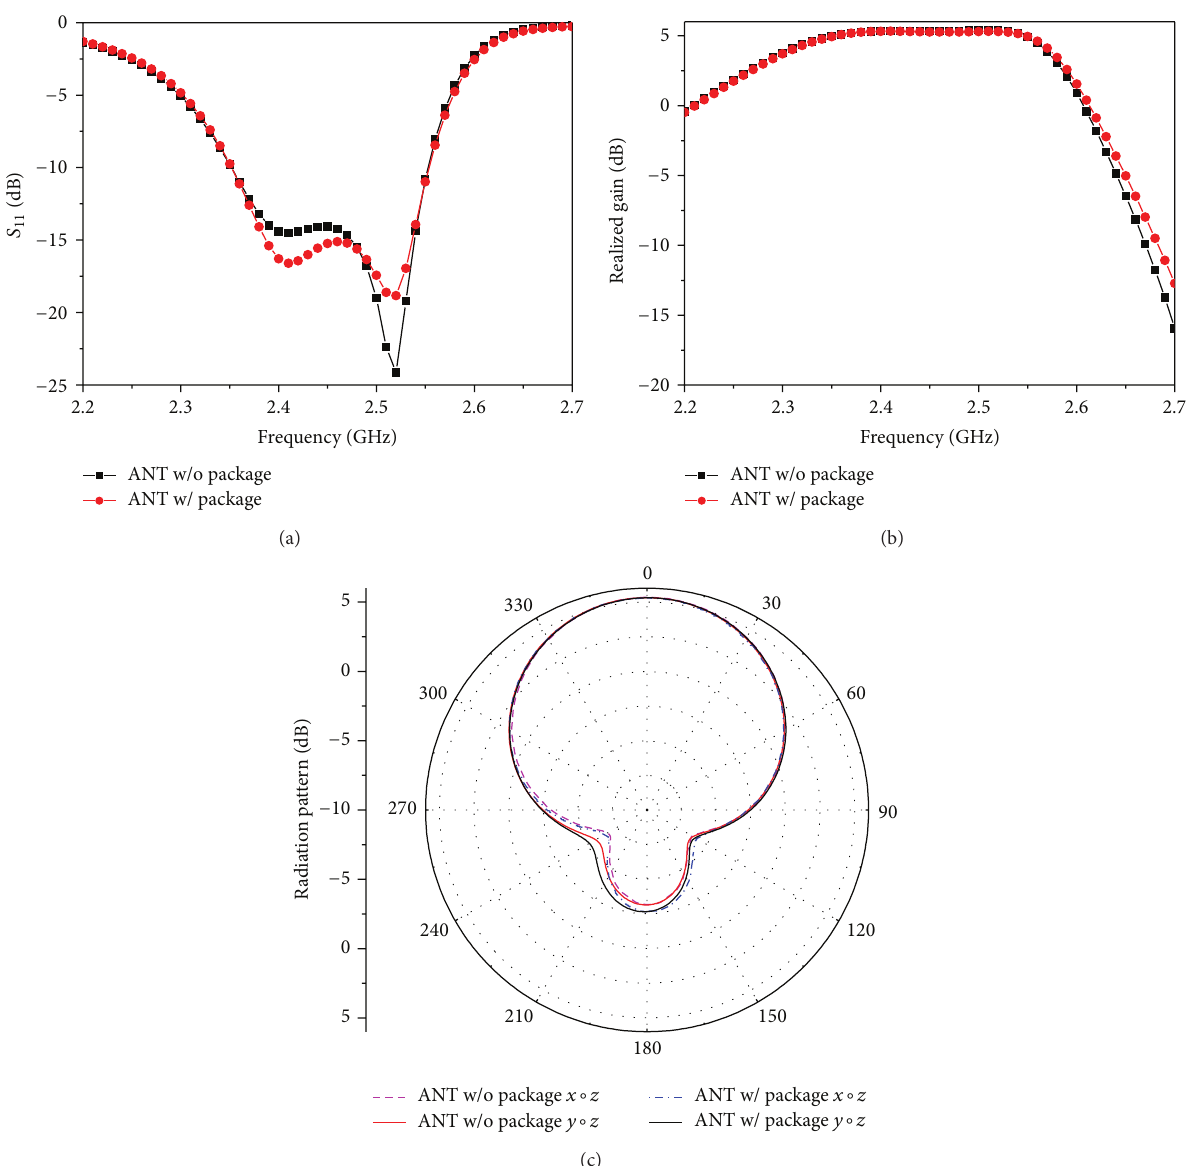
Figure 5: The calculated characteristics of the proposed system-on-chip antenna with and without the package: (a) 𝑆 11 , (b) realized gain, and (c) radiation